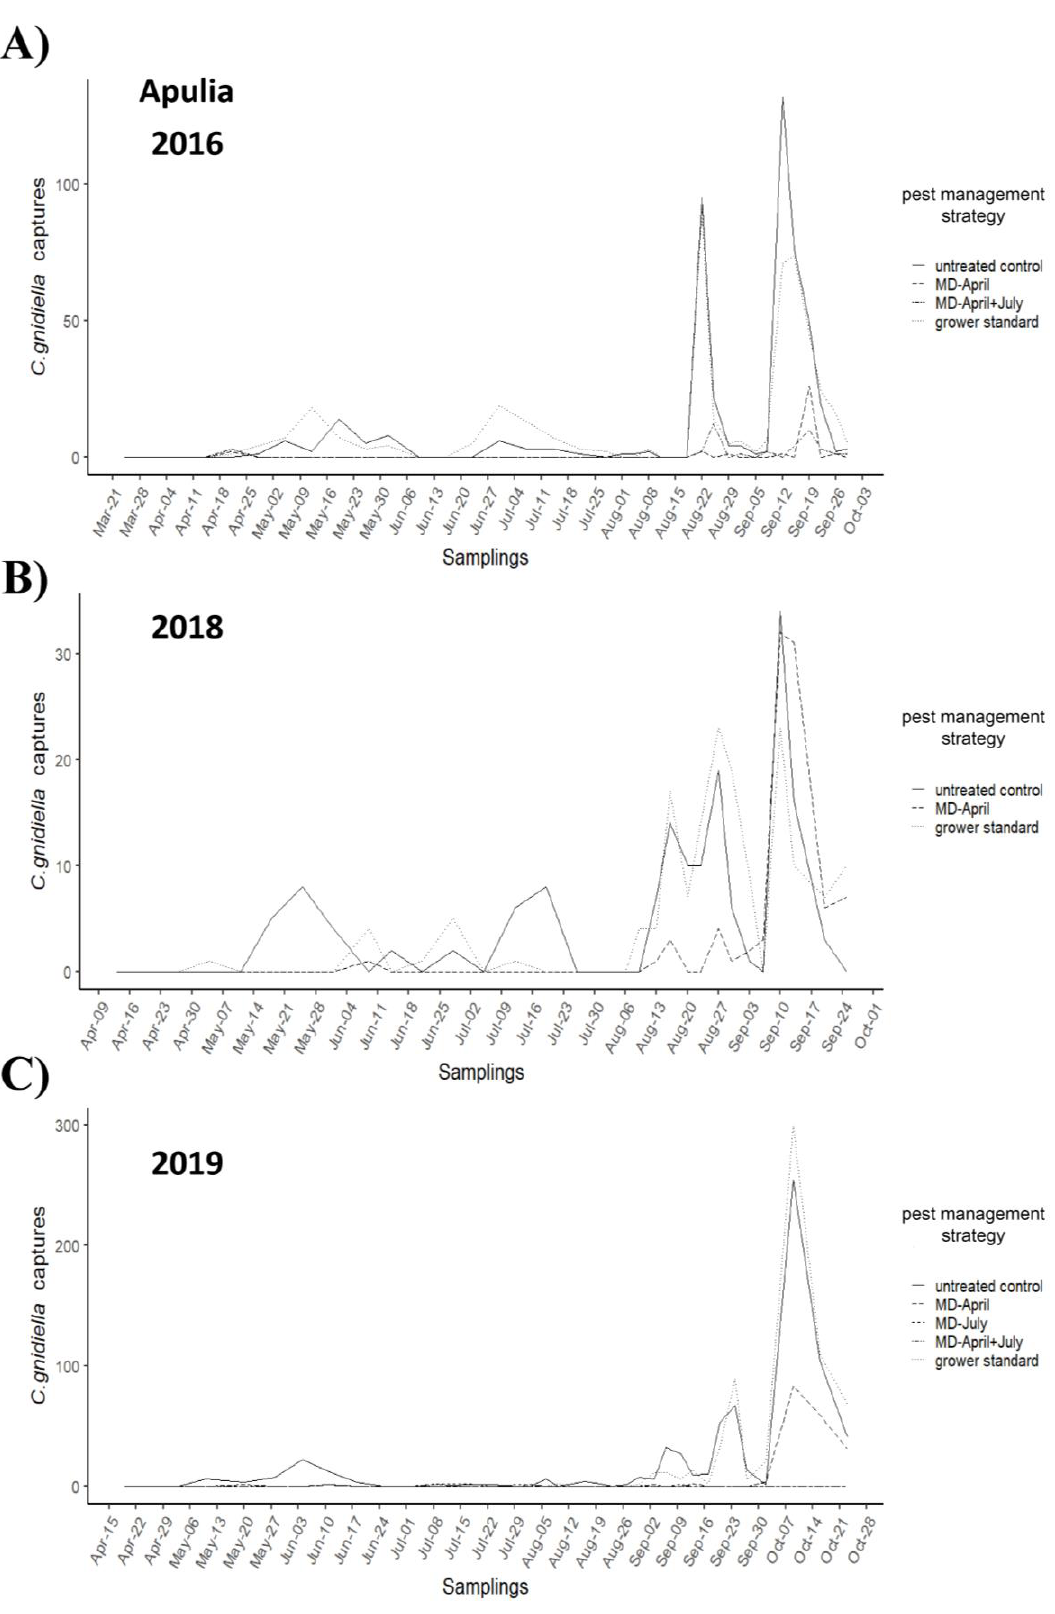
Figure 2. Cryptoblabes gnidiella flight trends in mating disruption (MD)-managed and untreated control plots in Apulia in 2016 ( A ), 2018 ( B ), and 2019 ( C ). In all years, there is a marked contrast in the number of catches between plots under MD (dashed lines), untreated control plots (solid line), and grower standard (dotted lines) especially from August onwards.